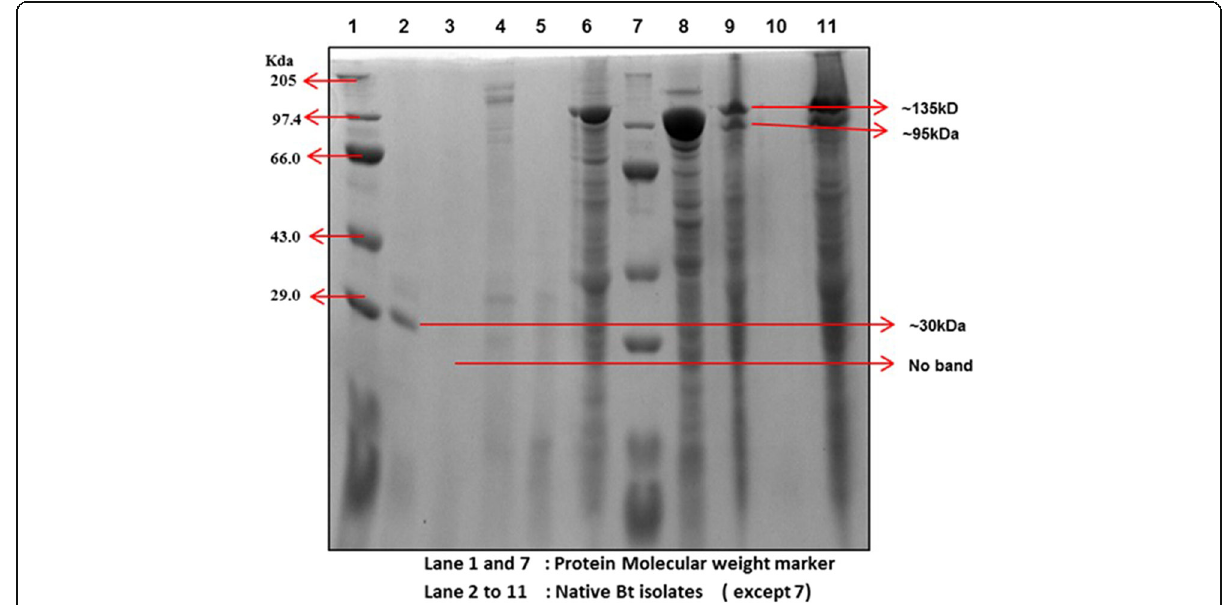
Fig. 2 Cry protein molecular weight variations among native isolates of Bacillus thuringiensis